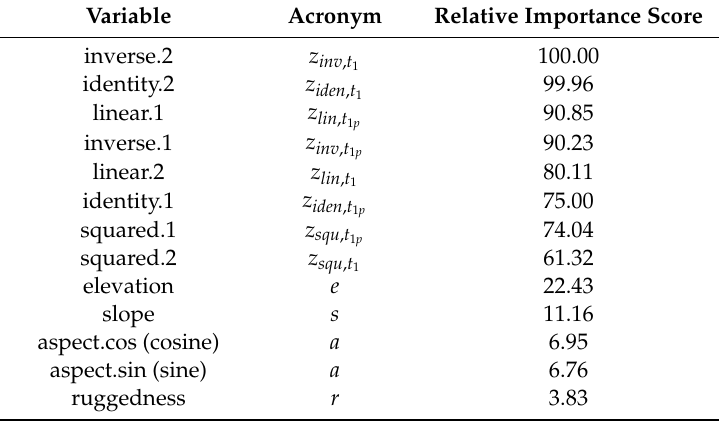
Table A3. RF model variable ranks and relative importance scores rounded to two decimal